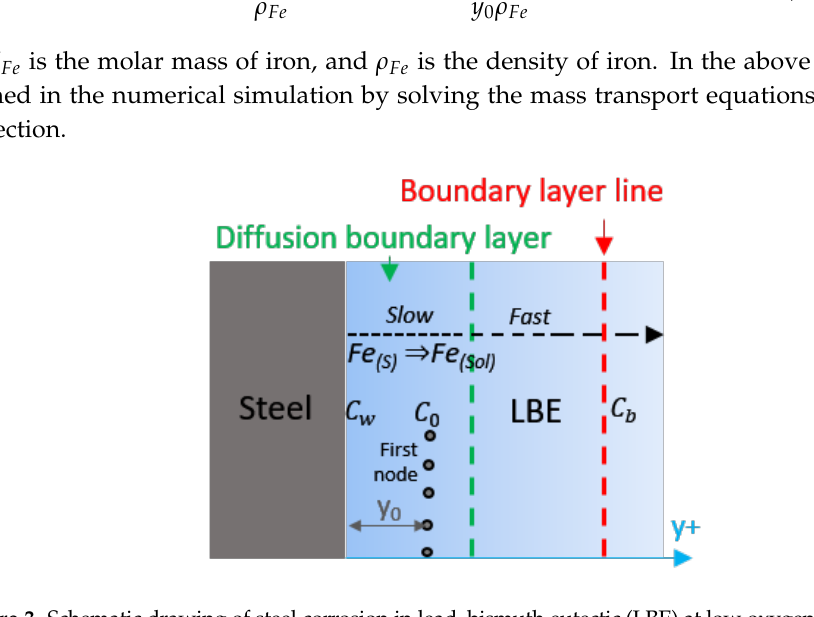
Figure 3. Schematic drawing of steel corrosion in lead–bismuth eutectic (LBE) at low oxygen concentration.